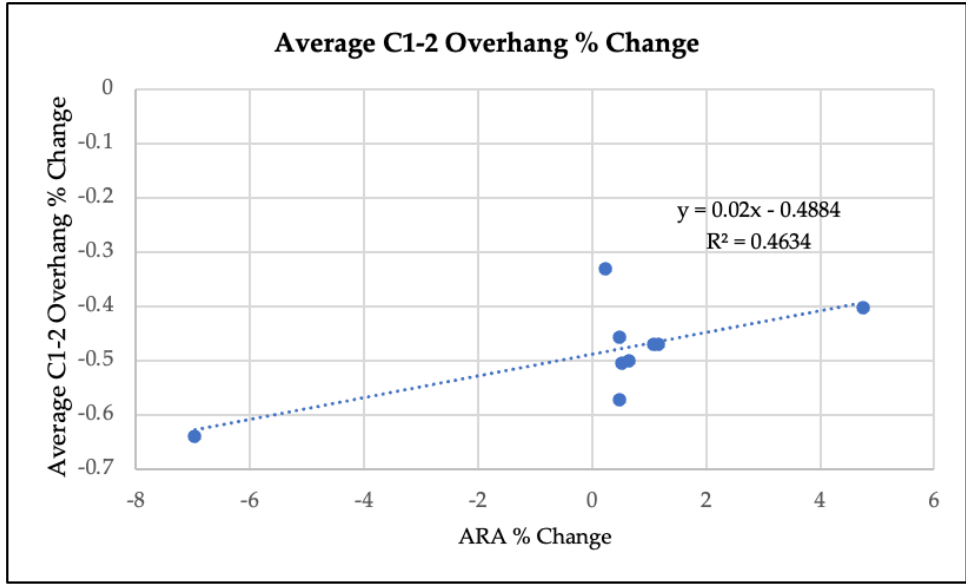
Figure 3. Linear regression analysis of average % change in C1-2 overhang versus the % change in ARA.